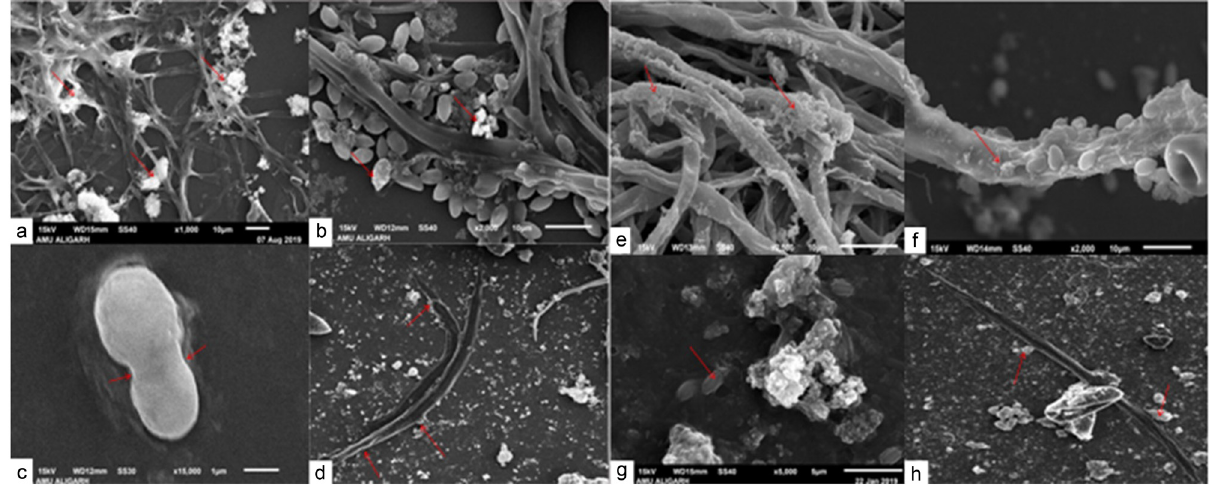
Figure 2: SEM images of test pathogens treated with SiO 2 - NPs and TiO 2 - NPs. ( a and b ) Mycelium and conidia of P. vexans sprayed with 0.20 mg/mL SiO 2 - NPs. ( c ) R. solanacearum handled with 0.20 mg/mL SiO 2 - NPs. ( d ) Nematode M. incognita handled with 0.20 mg/mL SiO 2 - NPs. ( e and f ) Mycelium and conidia of P. vexans handled with 0.20 mg/mL TiO 2 - NPs. ( g ) R. solanacearum treated with 0.20 mg/mL TiO 2 - NPs. ( h ) M. incognita J 2 treated with 0.20 mg/mL TiO 2 -